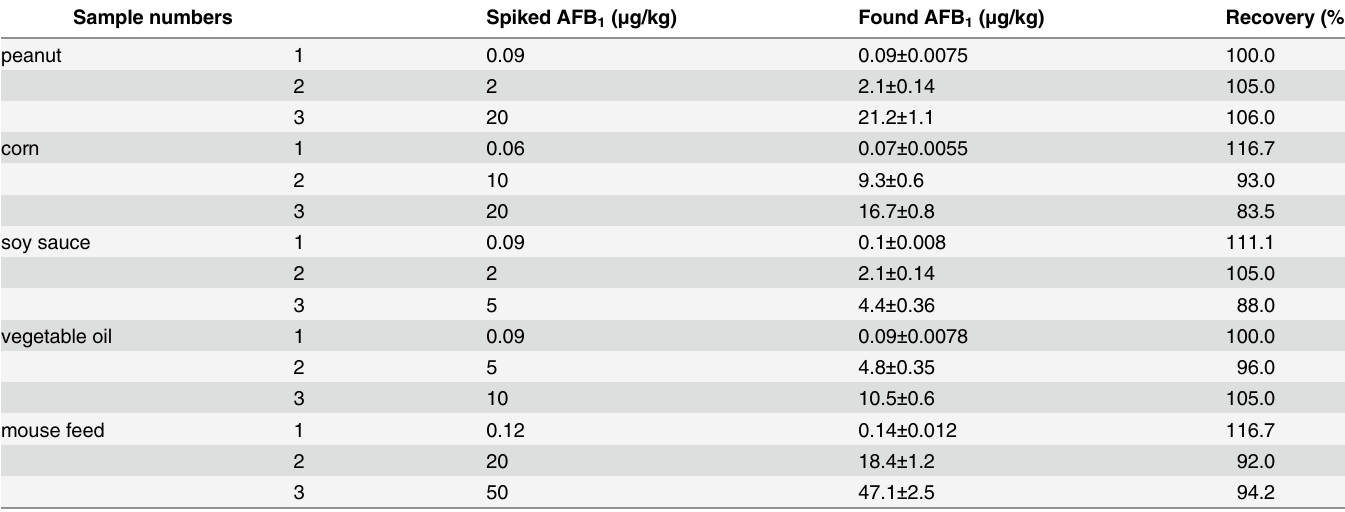
Table 3. Recoveries of CTRFIA sensing via spiked blank matrices (n =